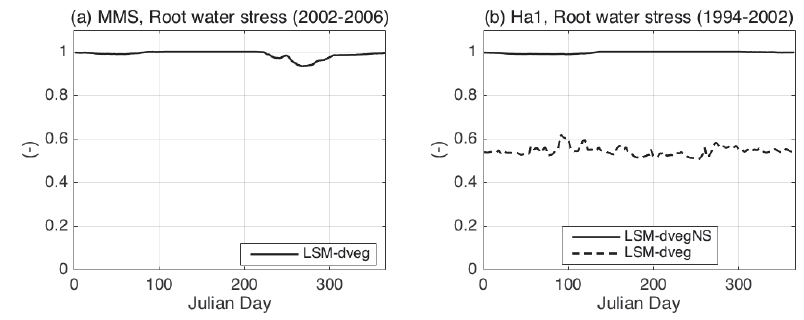
Figure 5. Daily root water stress factor in (a) MMS for 2002–2006 and (b) Ha1 for 1994–2002. Table 6. Correlation coefficients and RMSEs of hourly and daily fluxes between simulations and